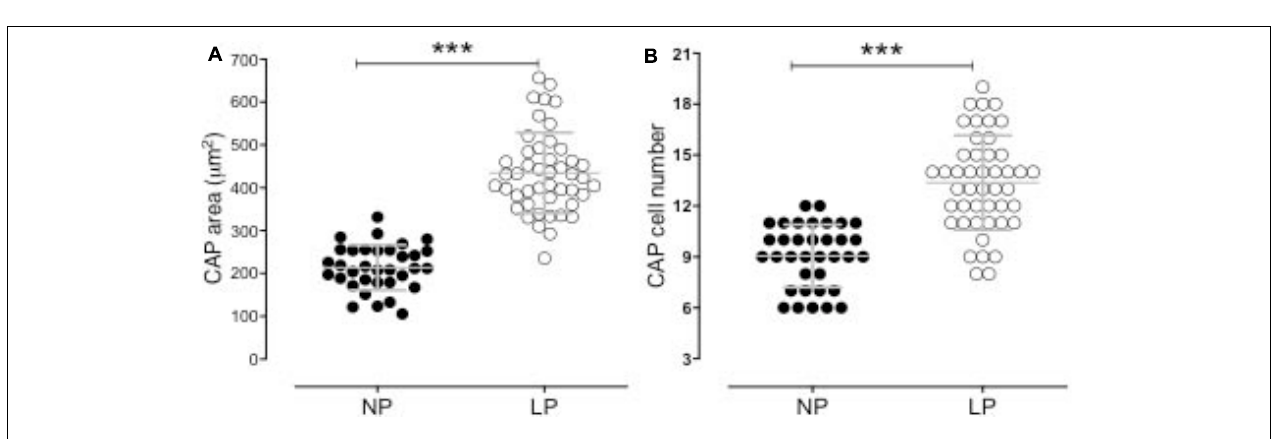
FIGURE 2 | The graphics represent the CM area (A) and Six2 positive cells in CM (B) . *** p < 0.0001.